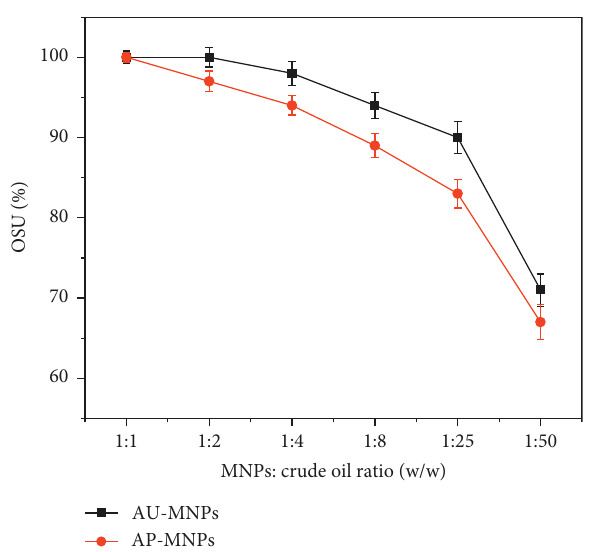
Figure 9: OSU of AU-MNPs and AP-MNPs versus MNPs : oil